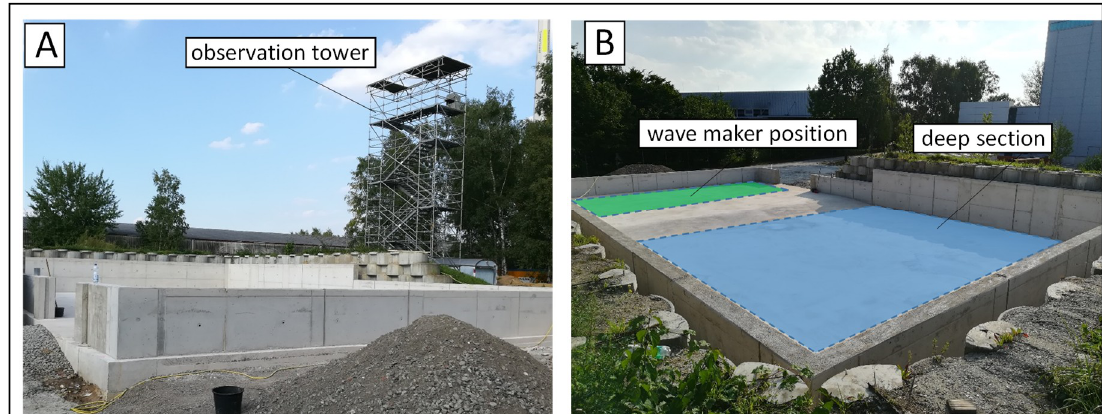
Figure 1. New outdoor wave basin during construction with observation tower ( A ) and empty basin after finishing the concrete works ( B ) in August 2017.